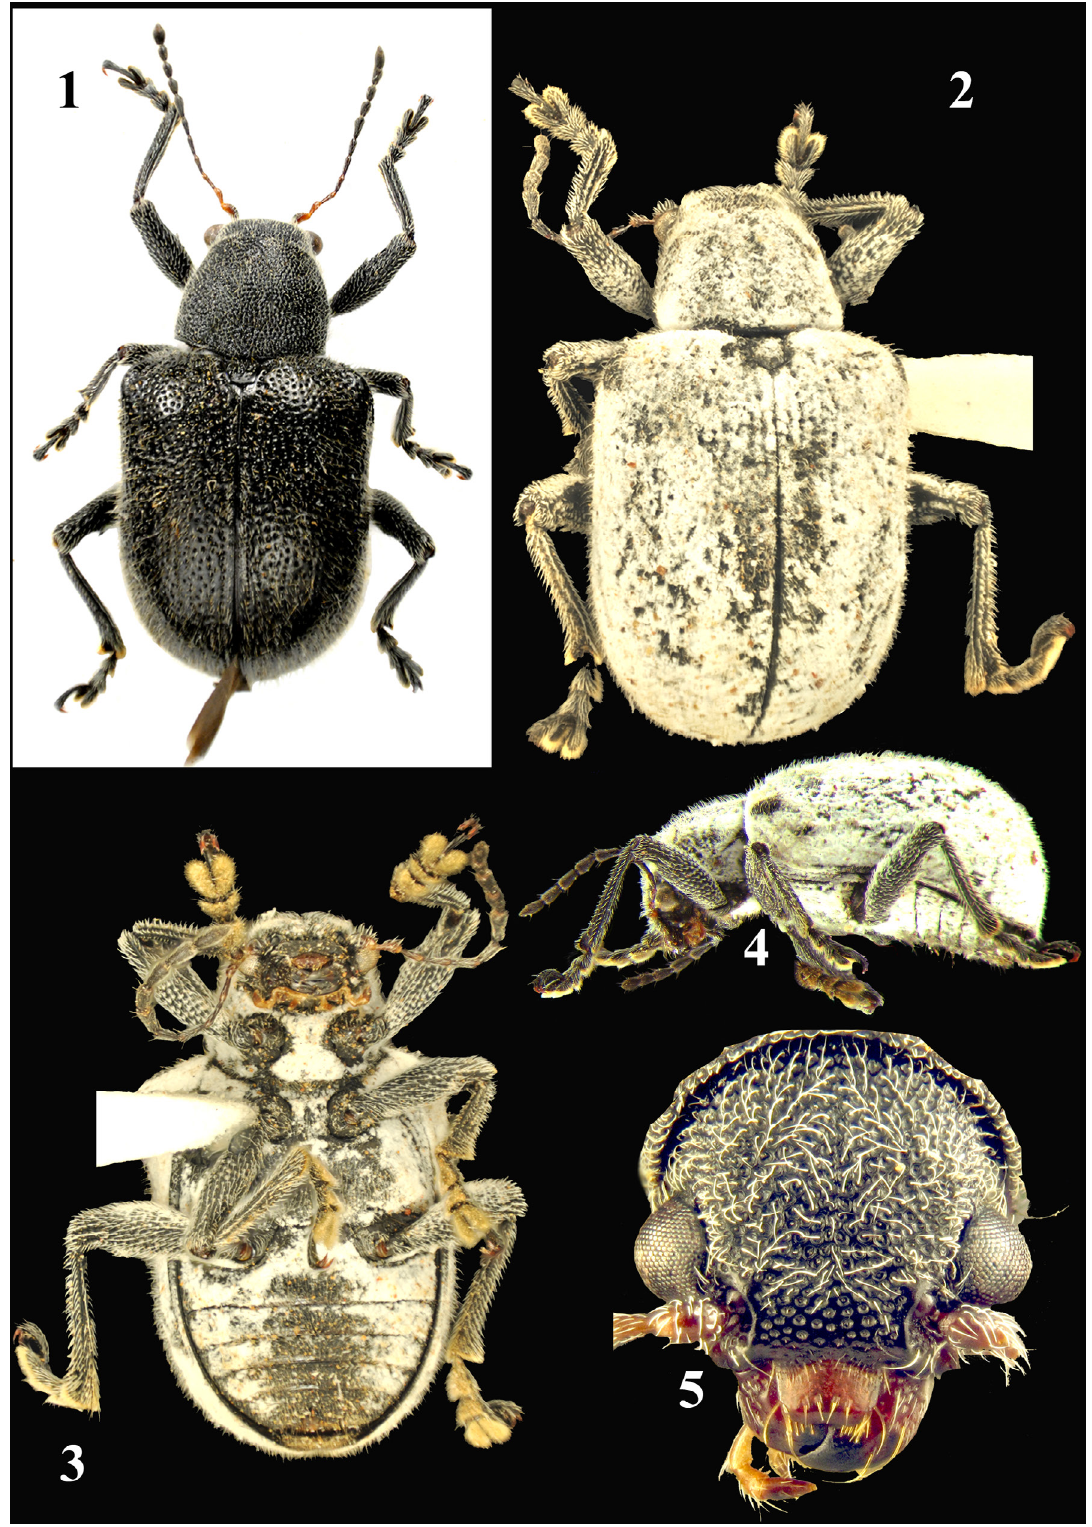
Figs 1–5. Fidia kanaraensis (Jacoby, 1895) comb. nov. 1 . Dorsal view of habitus after removing powdery encrustation. 2 . Dorsal view of habitus with powdery encrustation. 3 . Ventral view of habitus. 4 . Lateral view of habitus. 5 .